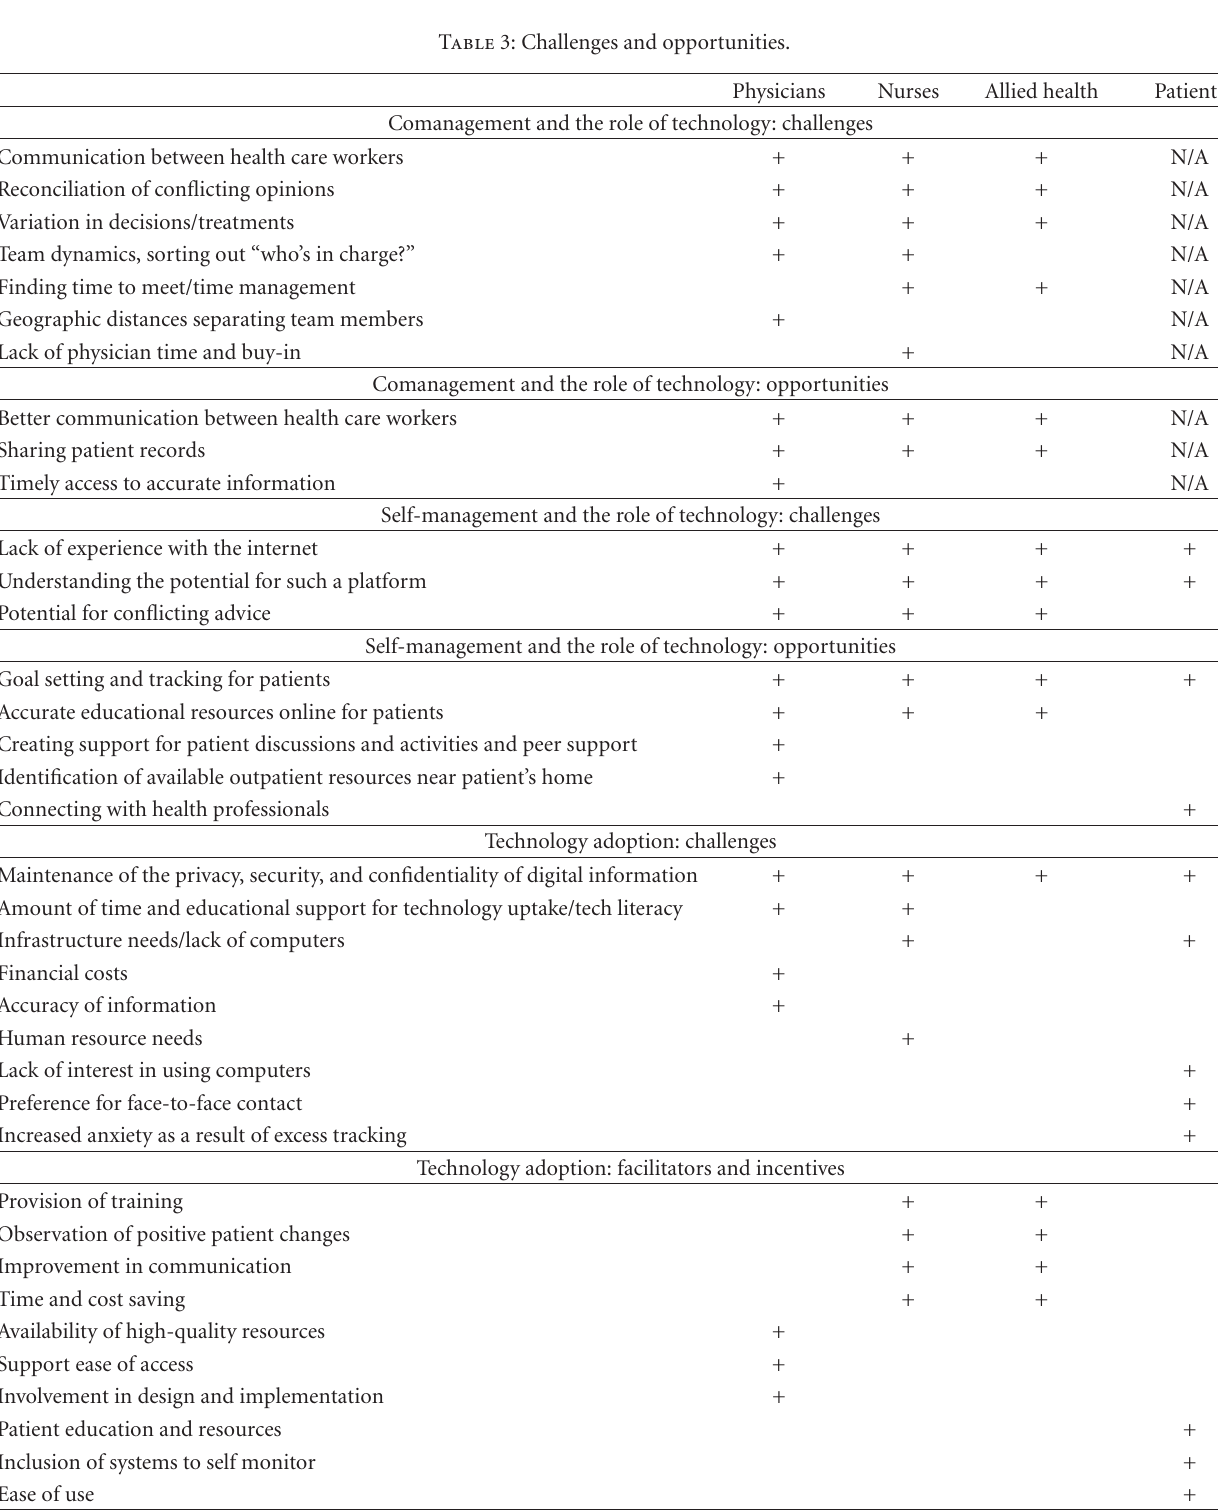
Table 3: Challenges and opportunities.